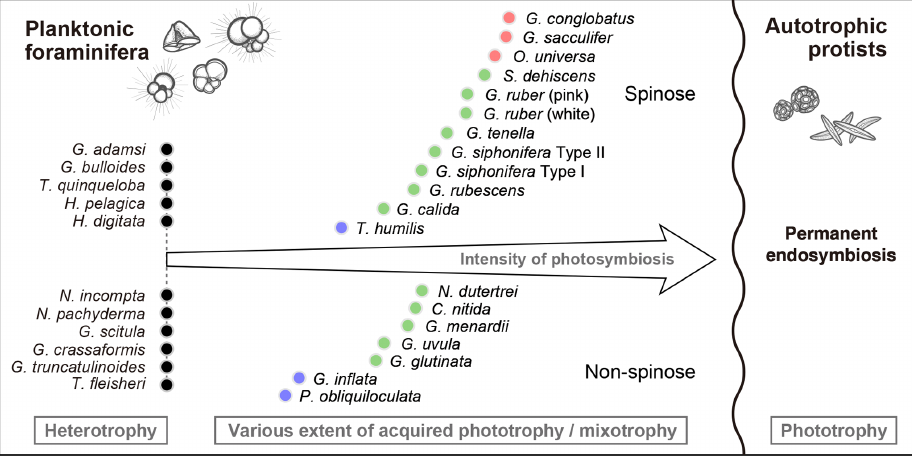
Figure 11. A conceptual diagram of the spectrum of planktonic foraminiferal photosymbiosis along the trophic gradient between permanent endosymbiosis (right) resulting in permanently integrated plastid (not found in planktonic foraminifera) and heterotrophy (left). Foraminiferal species are ordinated on the basis of their PC1 score of the principal component analysis conducted in this study (Fig. 9). The symbol colors correspond to those in Fig. 9. Foraminiferal photosymbiosis has been acquired regardless of their morphological features (i.e., spinose or non-spinose and macroperforate or microperforate). Please note that in planktonic foraminifera, the sexually reproduced new generation must acquire symbionts from the